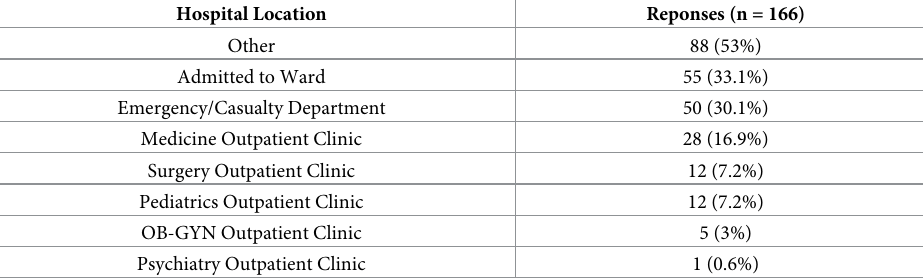
Table 7. If you were a patient in this hospital in the past week, where were you